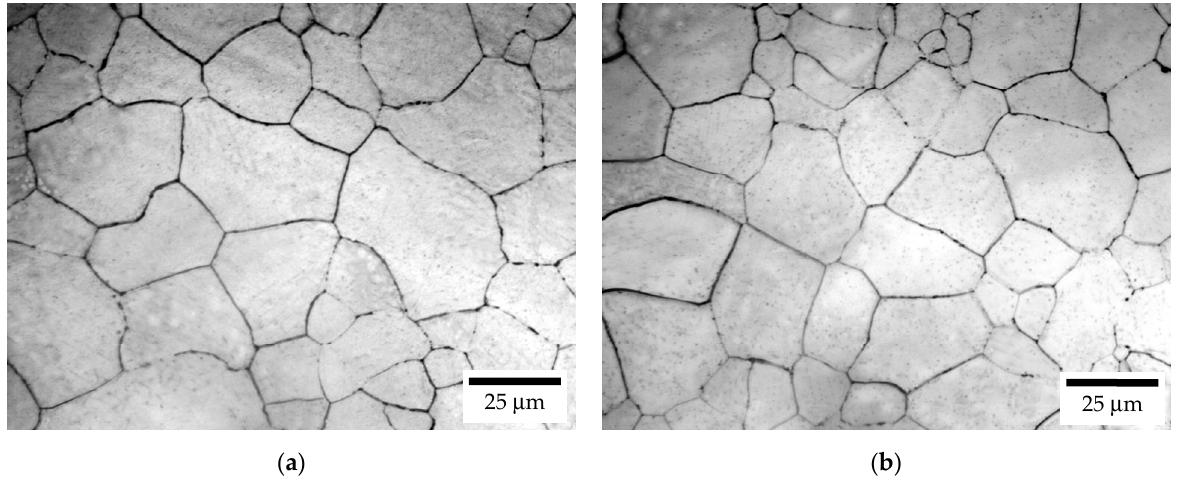
Figure 4. OM microstructure of ( a ) as-extruded Mg-0.5Ca-0.5Zr alloy and ( b ) as-extruded Mg-0.5Ca-1Zr alloy.